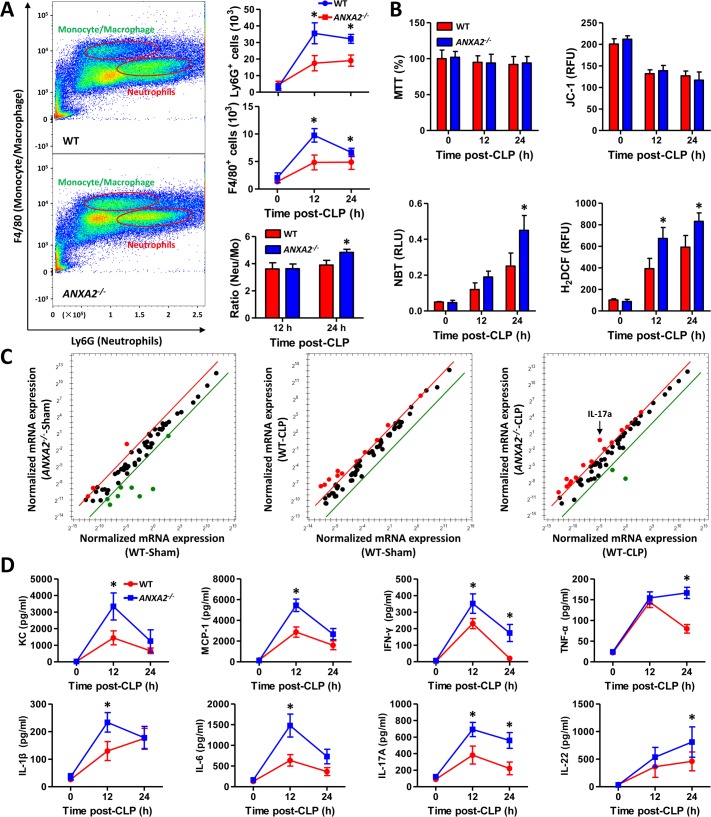
AnxA2 deficiency results in increased inflammatory response.(A) Scattergrams illustrating neutrophils (identified by Ly6G+F4/80-) and monocytes/macrophages (identified by Ly6G-F4/80+) positive events in peritoneal lavages from WT and anxa2
-/- mice at 24 h post-CLP. Ly6G+ and F4/80+ cell, and ratio of neutrophils to monocytes were quantified and shown as means±SD. (B) Peritoneal macrophages (PMs) were collected to determine viabilities (MTT), mitochondrial potential (JC-1), intracellular O2(-) production (NBT), and generation of ROS (H2DCF), respectively. Means±SD from triplicate. (C) PMs were also subjected to inflammatory response based gene detection using real-time qPCR array. (D) ELISA detecting cytokine secretion in peritoneal lavage from mice at 12 h and 24 h post-CLP, means±SD from triplicate. Data are representative of three experiments, one-way ANOVA (Tukey’s post hoc); *, p<0.05.